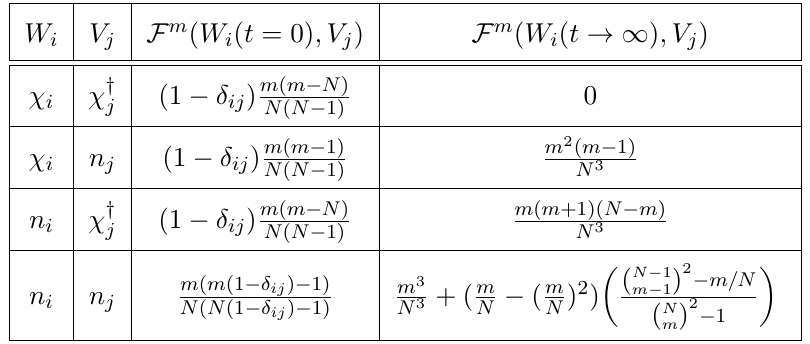
Table 1 . The early and late time value of the charge resolved OTOC in eq. (2.13) for each charge sector labelled by m and for different choices of the operators W and V